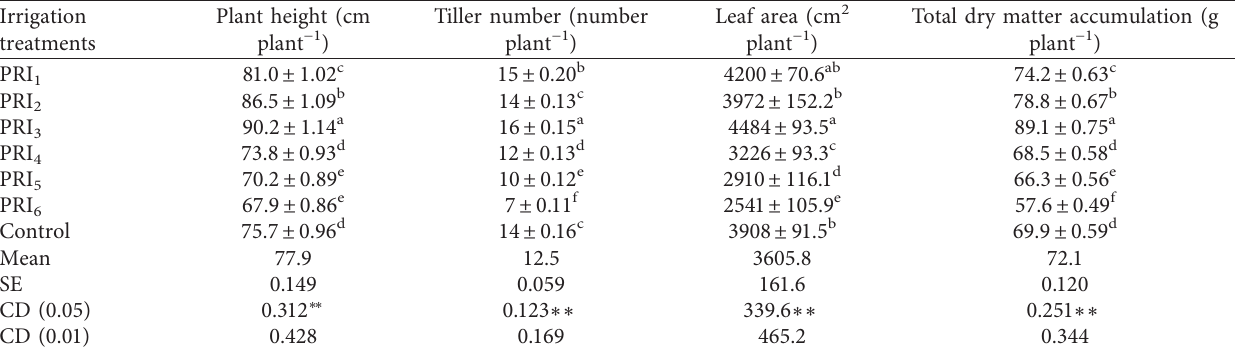
Table 2: Plant growth measurements of rice under the split root